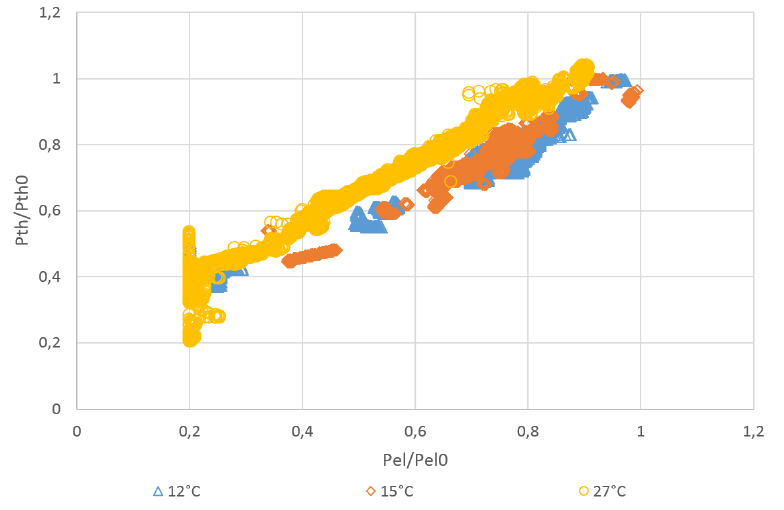
Figure 2. Operatinal field data for three ambient temperatures.